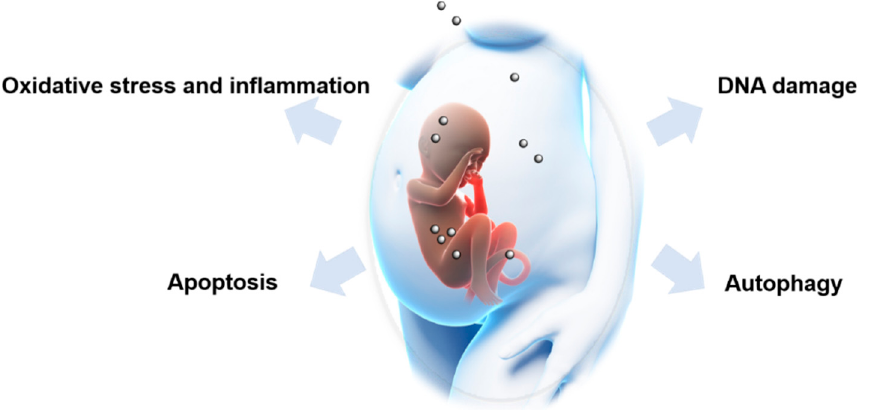
Figure 4. Possible mechanisms involved in nanoparticle-induced fetotoxicity. Oxidative stress and inflammation, DNA damage, apoptosis and autophagy are major mechanisms underlying nanoparticle-induced fetotoxicity.